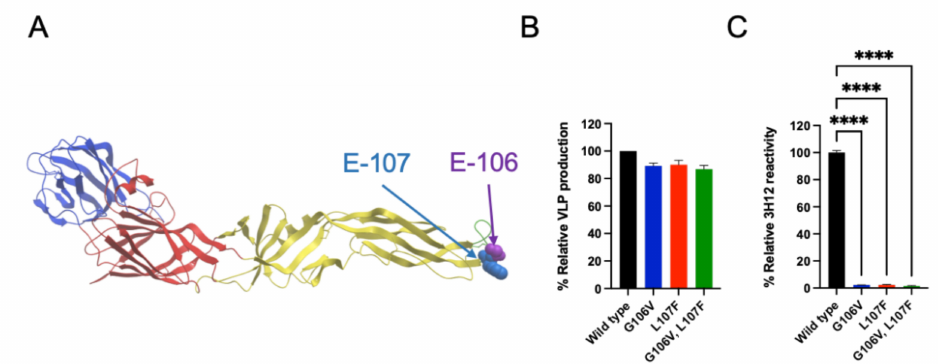
Figure 1. Construction of mutant JE DNA vaccines. ( A ) Location of the mutation introduced into the escape mutant using JEV and 3H12. The E protein ribbon diagram is based on Protein Data Bank (PDB) accession No. 3P54. Domains I, II, and III are denoted in red, yellow, and blue, respectively. The fusion loop (FL) region is indicated in green. The 106th and 107th amino acid residues of the E protein are highlighted as spheres. ( B ) Relative virus-like particle (VLP) production from cells transfected with JE DNA vaccines. VLPs were produced in 293T cells transfected with DNA vaccines, and quantification was conducted using ELISA. The VLP production was expressed as the optical density (OD) of mutated VLP relative to that of wild-type (OD of mutated JE vaccine/OD of wild-type vaccine). ( C ) The reactivity of 3H12 to FL-mutated JEV VLPs. The VLPs were produced in